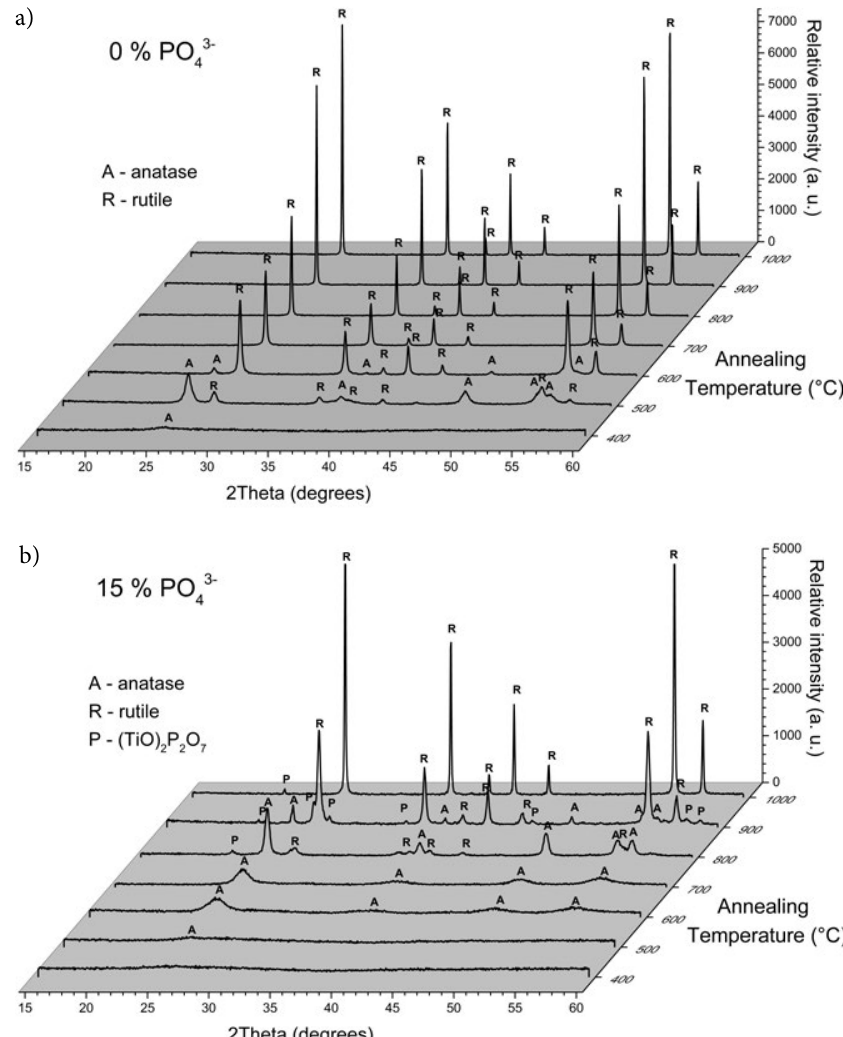
Figure 5. Evolution of the recorded powder diffraction patterns with an increasing annealing temperature (a: undoped TiO nanoparticles doped with 15 mol% of phosphate ions).